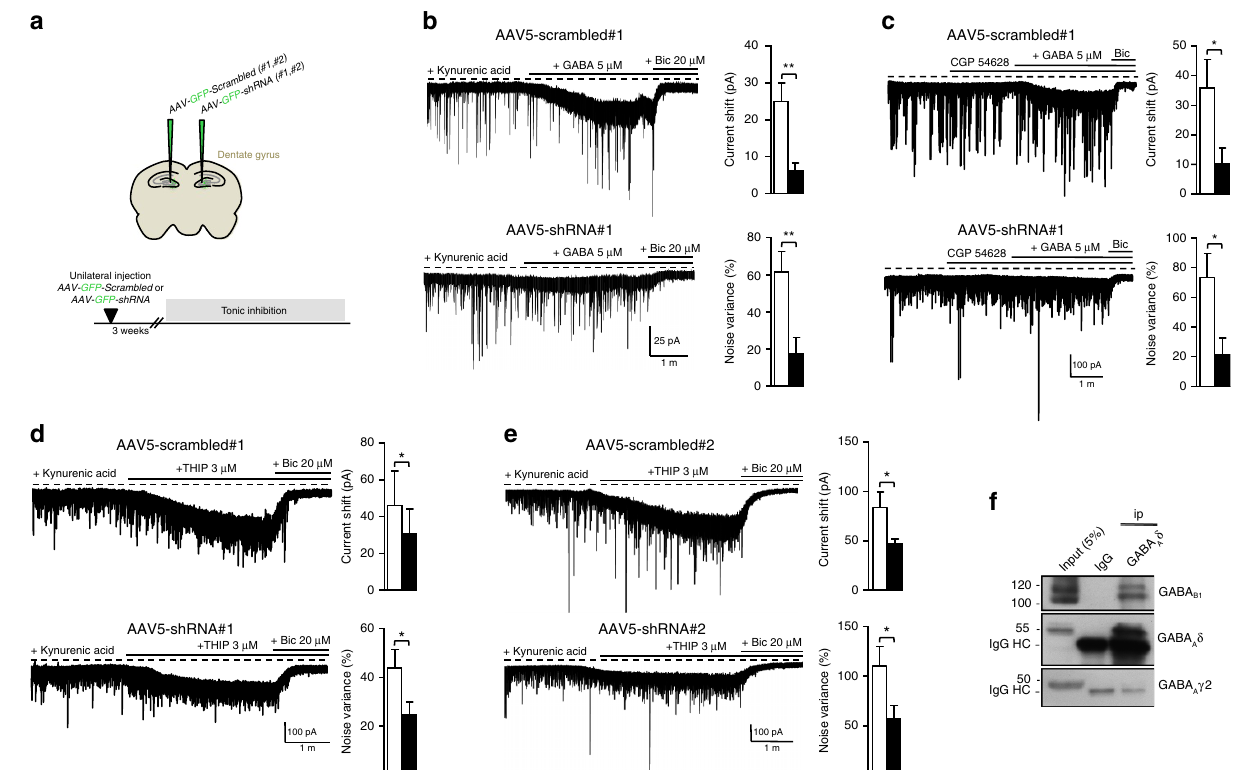
Figure 5 | Shrm4 silencing in vivo mediates tonic inhibition in the hippocampus. ( a ) Schematic of injection of AAV5-scrambled#1 (or #2) and AAV5-shRNA#1 (or #2) into opposing DG of rat, with time line for recovery and experiments. Slices were prepared 3 weeks after injection. ( b ) Tonic currents activated by 5 m M GABA in the presence of kynurenic acid (3mM) of DG granule cells (DGGCs) in acute brain slices taken from hemispheres injected with either AAV5-shRNA#1 or AAV5-scrambled#1. GABA-mediated current shift and noise variance were lower in slices injected with AAV5-shRNA#1 compared with AAV5-scrambled#1 (current shift: n ¼ 10, 12; ** P ¼ 0.0050; t -test; noise variance: n ¼ 9, 11; ** P ¼ 0.025; t -test). ( c ) Tonic currents activated by 5 m M GABA in the presence of CGP54626 (5 m M) of DGGCs in acute brain slices taken from hemispheres injected with either AAV5-shRNA#1 or AAV5-scrambled#1. A lower GABA-mediated current shift and current variance in slices pre-treated with CGP54268 from AAV5-shRNA#1 compared with AAV5-scrambled#1 injected animals were observed (current shift: n ¼ 6, 7; * P ¼ 0.0352; t -test; noise variance: n ¼ 5, 7; * P ¼ 0.0215; t -test). ( d ) THIP (3 m M)-activated currents of DGGCs in the presence of kynurenic acid (3mM). THIP current shift and current variance were lower in slices injected with AAV5-shRNA#1 compared with AAV5-scrambled#1 (current shift: n ¼ 9, 11; * P ¼ 0.0225; t -test; noise variance: n ¼ 10, 13; * P ¼ 0.0419; t -test). ( e ) THIP (3 m M)-activated currents from DGGCs in the presence of kynurenic acid (3mM). A lower THIP current shift and current